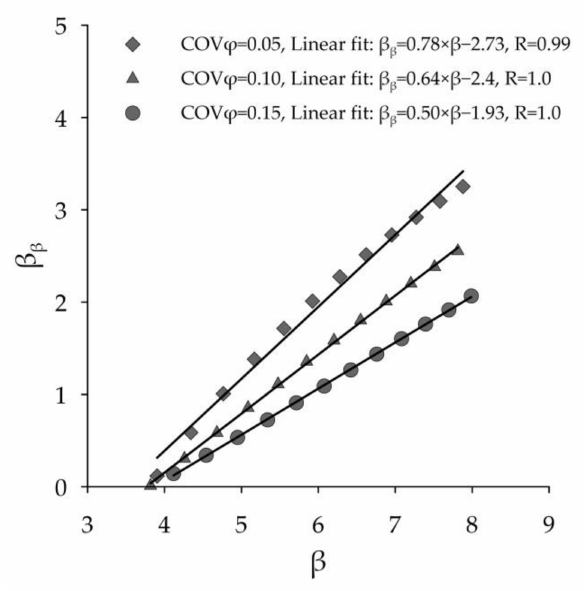
Figure 4. The relation β − β β for different foundation widths and variation coefficients of the soil’s internal friction